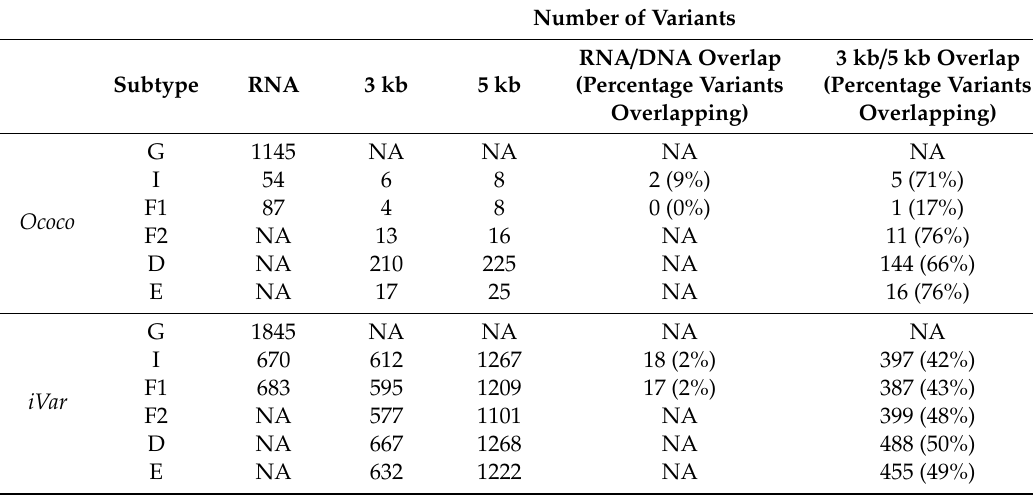
Table 4. The number of polymorphic intra-host variants for each subtype identified by the two variant callers that completed analysis, iVar and Ococo. The percentages shown are the number of overlapping variants divided by the mean number called from the focal